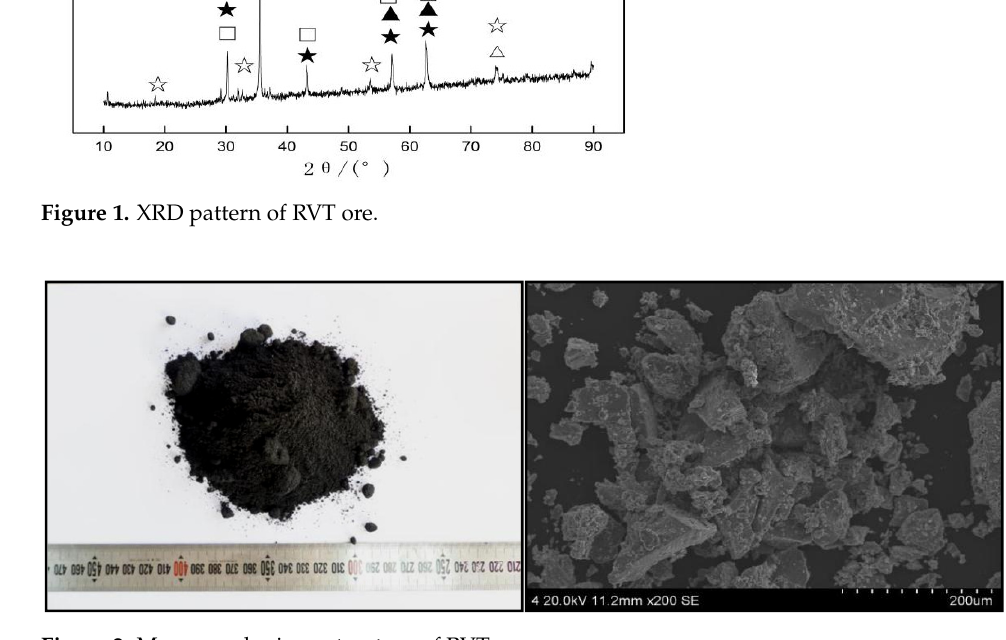
Figure 2. Macro- and micro- structure of RVT ores.